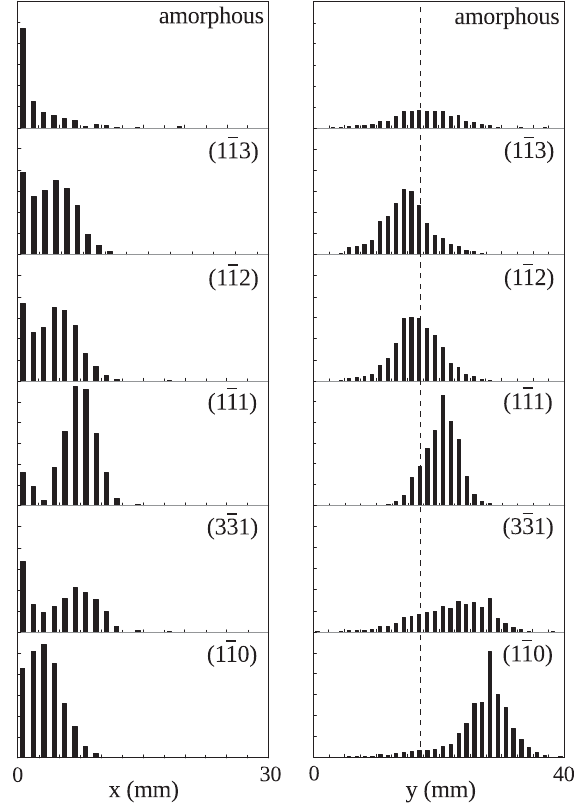
FIG. 6. Beam profiles for different angles of the goniometer [as shown in Fig. 4(a)] corresponding to the deflection by different crystal